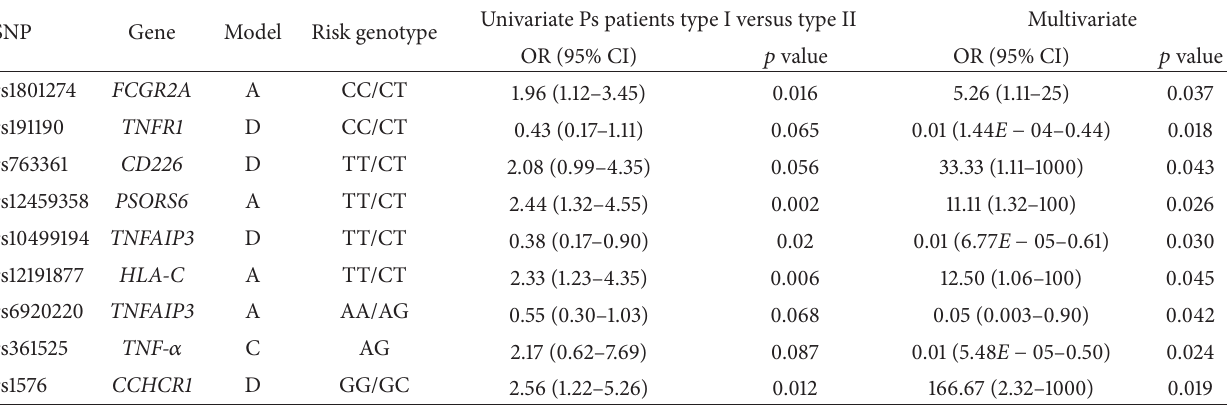
Table 3: Results of univariate and multivariate linear regression analyses (155 patients with psoriasis type I versus 36 cases with psoriasis type II). SNPs with 𝑝 < 0.1 in the univariate analysis were included in the multivariate analysis. Only polymorphisms that were significant in the multivariate analysis are